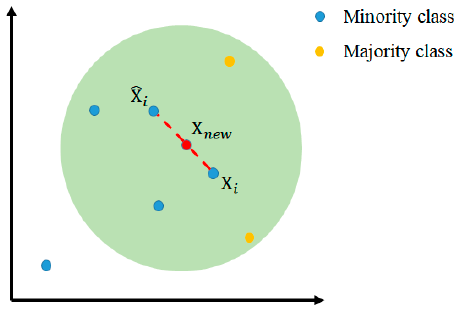
Figure 8. Conceptual representation of the SMOGN algorithm.